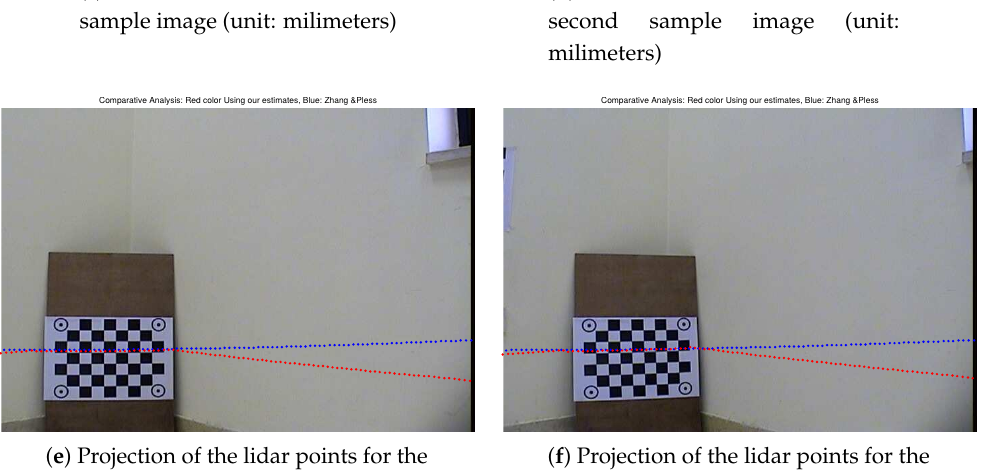
Figure 16. Two sample images and their corresponding lidar measurements from the newly recorded dataset. ( a , b ) show the reprojection of the grid points onto the image planes with estimated extrinsic world-camera calibration parameters; ( c , d ) show lidar points that were detected in the same plane of the calibration pattern in red color circles, where other lidar points are shown in blue dots (angular resolution is 1 ◦ ); ( e , f ) show forward projection of the lidar points to the image planes using (1) the Zhang and Pless estimated parameters (points shown in blue color) and (2) using the estimates from our proposed approach (points shown in red